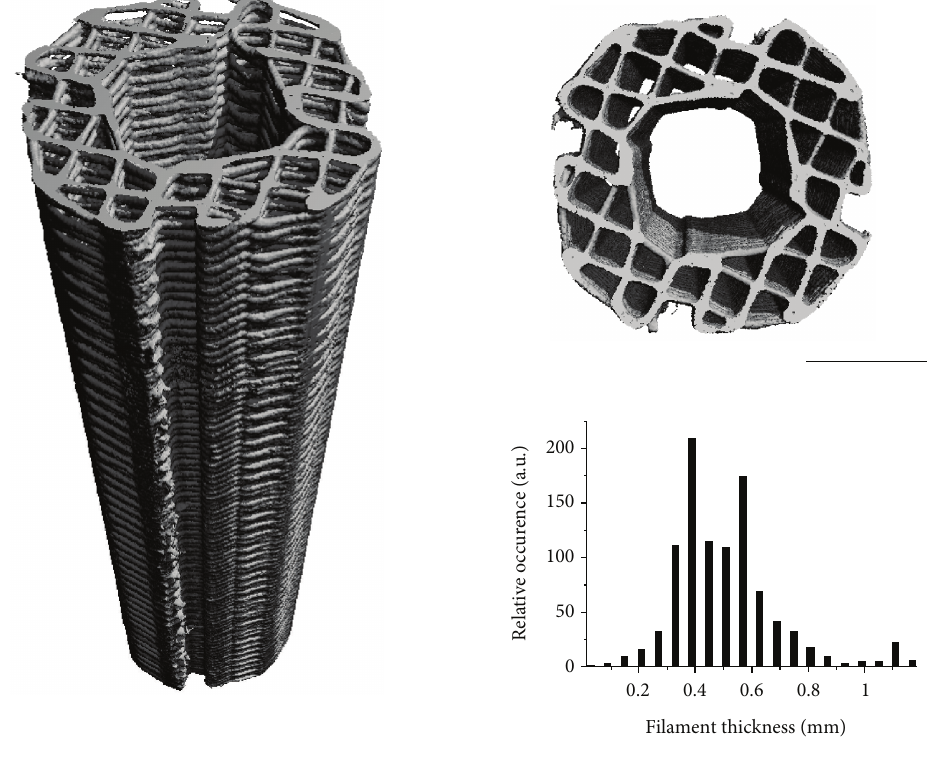
F 3: Side and top view of a PCL scaffold for tibia segmental defect regeneration, visualised by microcomputed tomography. e fabrication technique results in scaffolds with well-controlled architecture as evidenced by the narrow �lament thickness distribution, leading to a porosity (volume fraction available for tissue ingrowth) of 60 , with interconnected pores. Scale bars are %